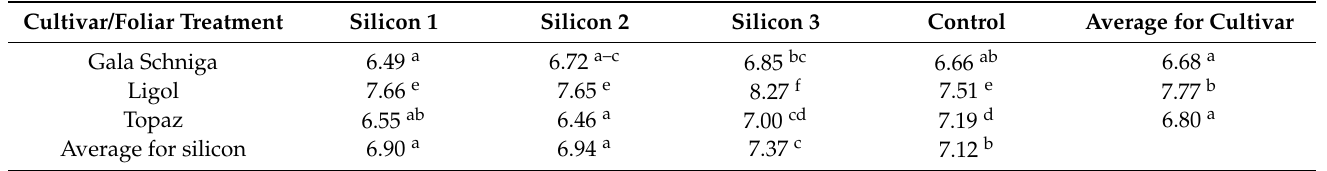
Table 5. The size of fruits of apple trees depends on cultivar and foliar silicon treatment (cm).